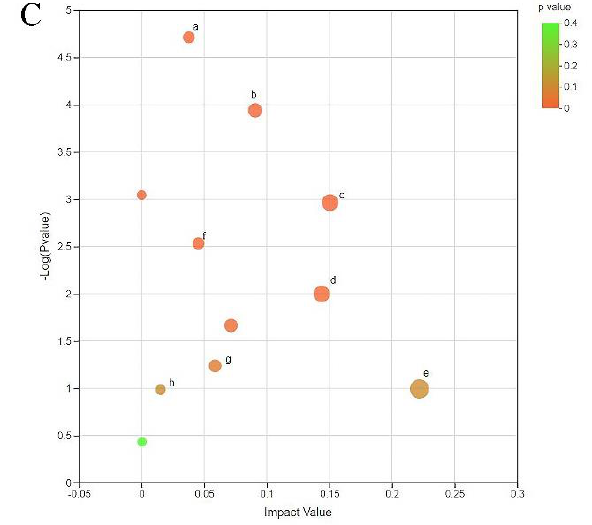
Figure 6. ( A ) DEM metabolic pathway enrichment in CG vs. EG34 groups (KEGG